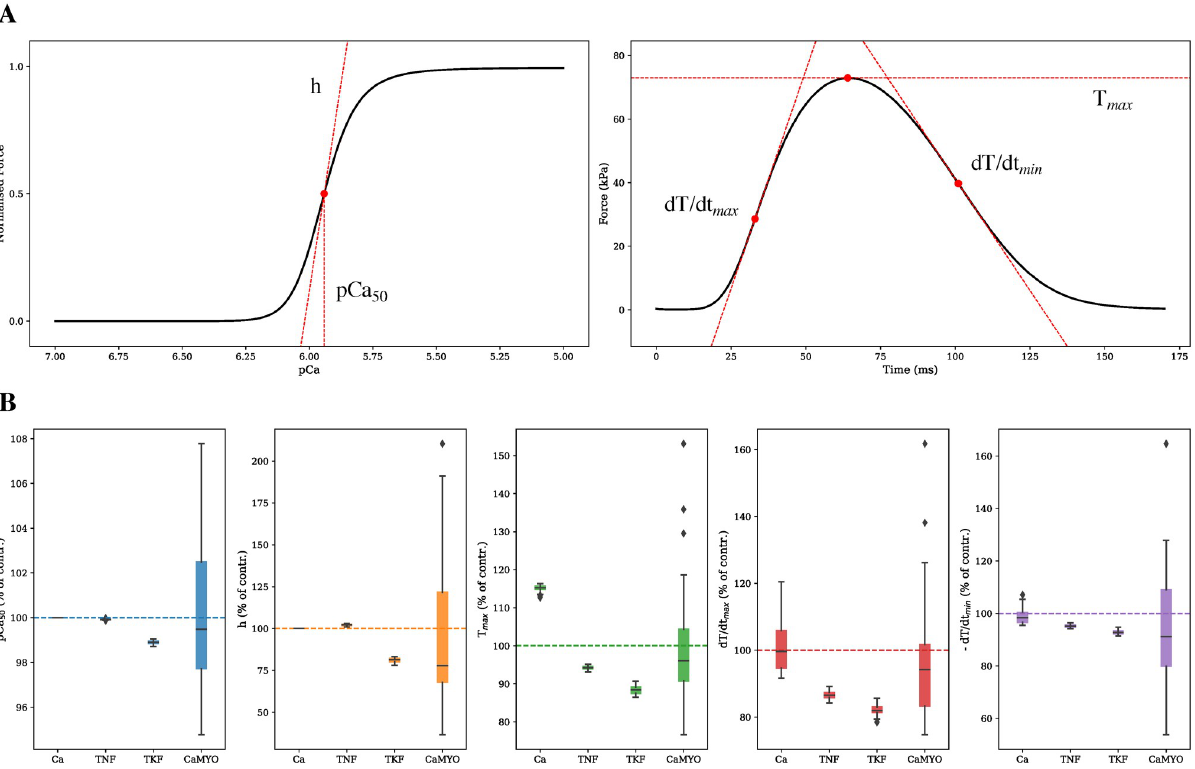
Fig 9. Isometric force-calcium relationship and generated active tension properties from the recovered rat model parameter space. (A) Calcium sensitivity (pCa 50 ) and Hill coefficient ( h ) features are extracted from the force-calcium curve, while peak tension (T development (dT/dt max ) and decay (dT/dt min ) are extracted from the twitch transient. (B) Distributions of extracted pCa 50 (blue), h (orange), T max (green), dT/dt (red), dT/dt (purple) values are compared with the respective ZSF1 rat model baseline values (dashed lines). max min